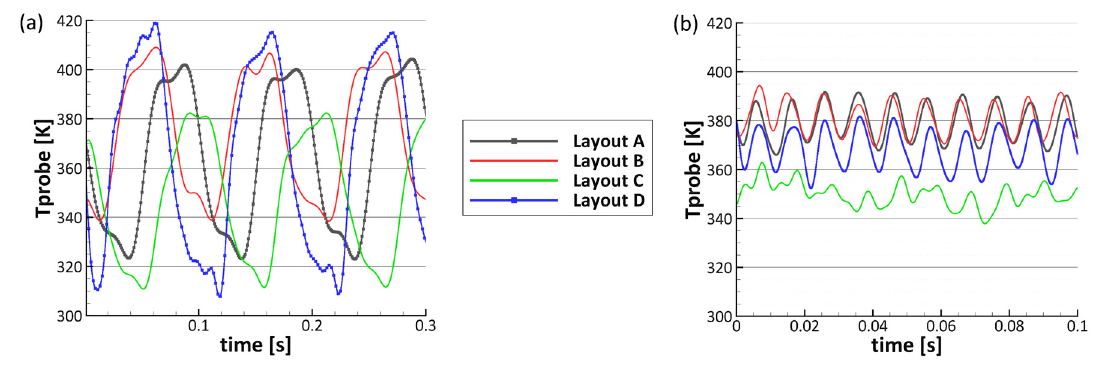
Figure 13. Di ff erent layout center temperature fluctuations at 10 Hz ( a ) and 100 Hz ( b ). Figure 13. Different layout center temperature fluctuations at 10 Hz ( a ) and 100 Hz ( b ).